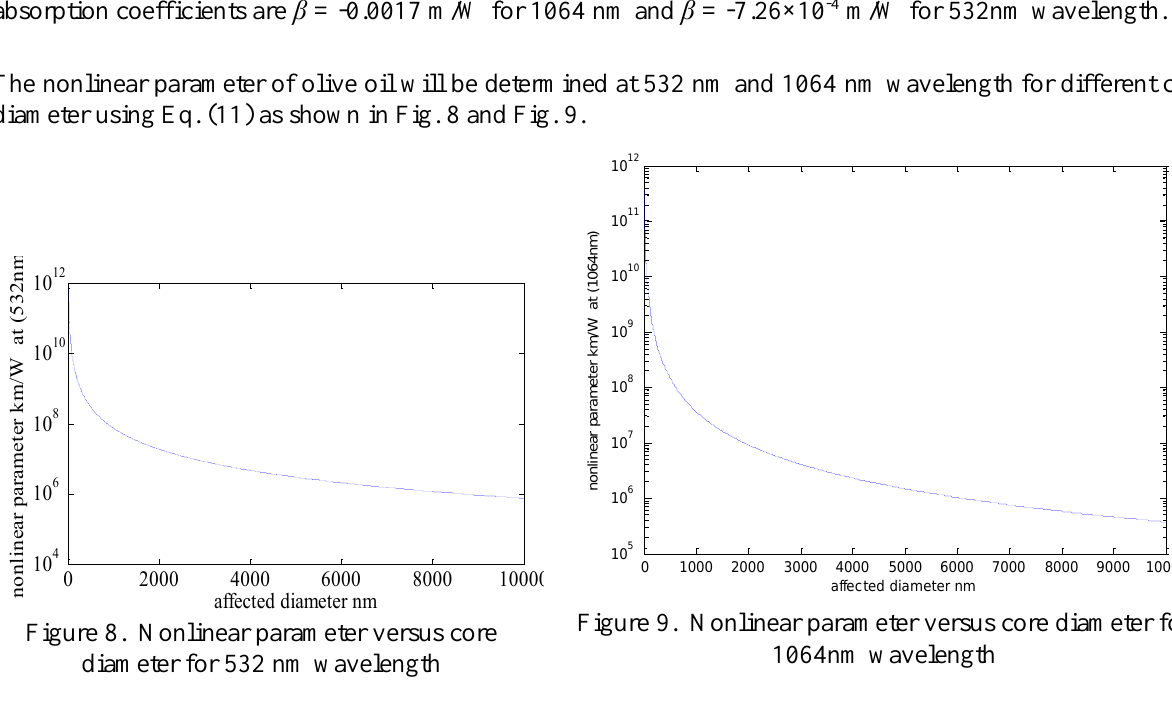
Figure 9. Nonlinear parameter versus core diameter for 1064nm